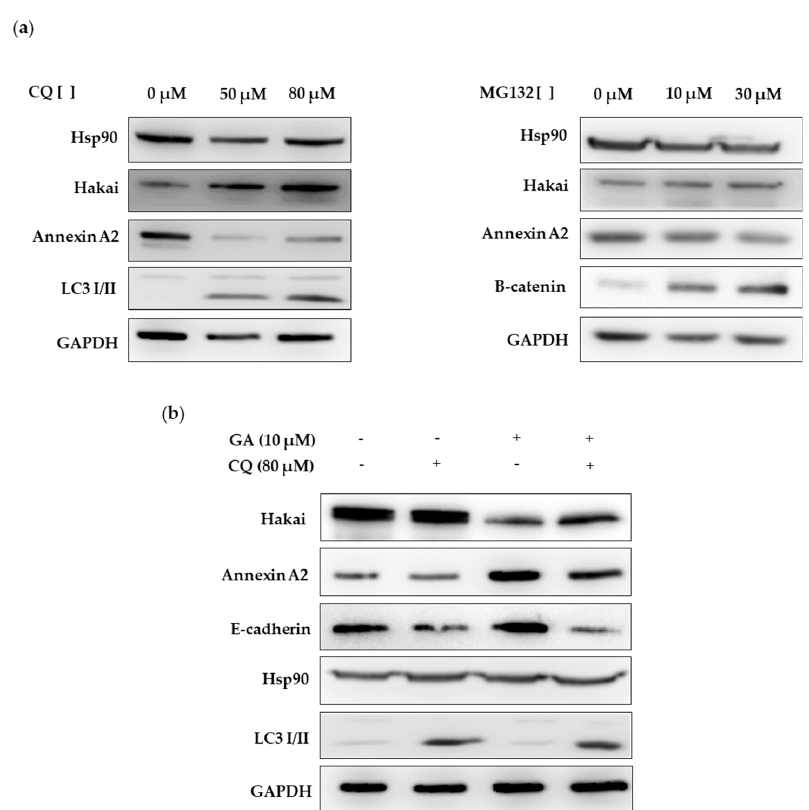
Figure 7. Geldanamycin increases Hakai protein degradation in a lysosome-dependent manner: ( a ) HEK293T cells were treated with chloroquine (left panel) and with MG132 (right panel) for 24 h at the indicated concentrations. Cell lysates were collected and evaluated by western blot analyses with Hakai and Annexin A2 antibodies. ( b ) HEK293T cells were transiently transfected with pcDNA-Flag-Hakai (4 µ g), pBSSR-HA-Ubiquitin (3 µ g) and pSG-v-Src (3 µ g) for 48 h. The day after transfection, cells were treated with chloroquine and geldanamycin at the indicated concentrations for 24 h. Cell lysates were collected and protein expression was evaluated by western blot analyses using the indicated antibodies. Chloroquine treatment-induced Hakai protein levels recovery during geldanamycin treatment. LC3 I / II levels was used as a positive control in chloroquine treatment and β -catenin as positive control in MG132